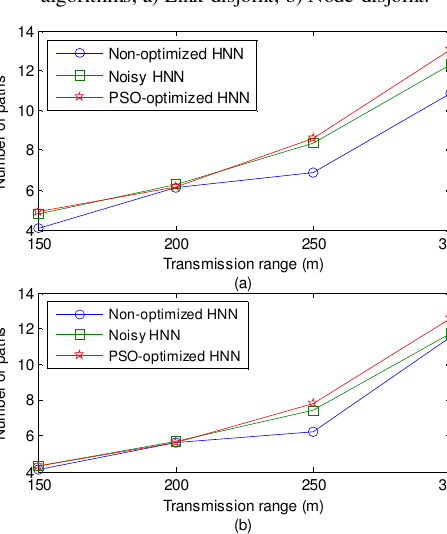
Fig. 5. Reliability of different HNN-based path selection algorithms; a) Link-disjoint, b) Node-disjoint.